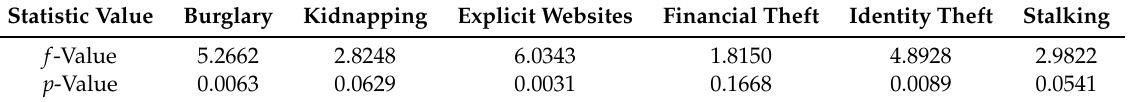
Table 10. Statistical analysis of gender related differences of danger assessment results using the Analysis of variance (ANOVA) method. In the table we see the f -value and p -value for Female and Male genders.